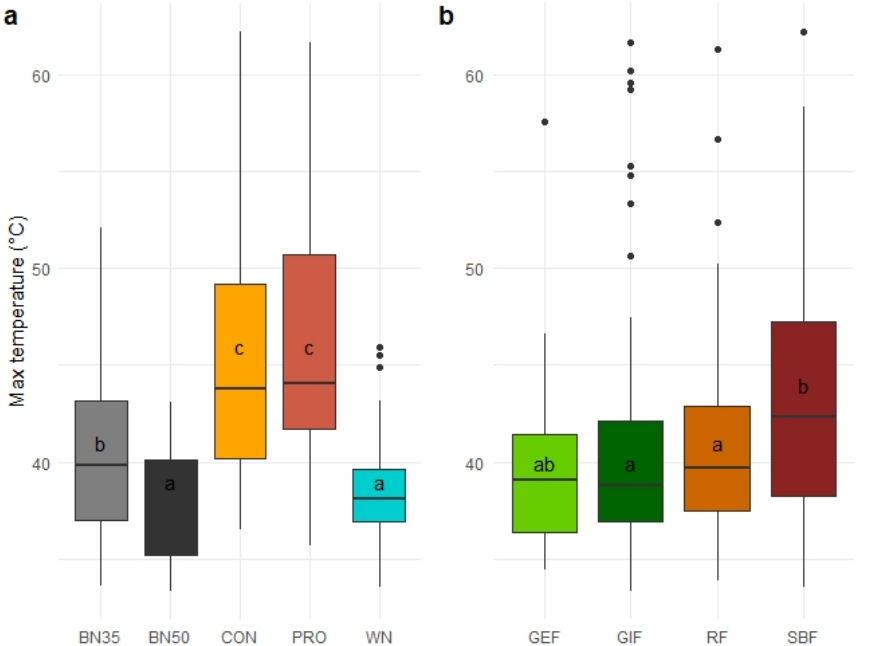
Figure 3. Maximum fruit surface temperature (FST) according to: ( a ). treatment (BN35 = Black net 35, BN50 = Black net 50, WN = White net, CON = control and PRO = protectants), and ( b ). fruit condition (RF = red fruit, GEF = green external fruit, GIF = green internal fruit, and SBF = sunburned fruit). The box represents interquartile range (IQR); the upper (Q3) and lower (Q1) quartiles are the ends. The line in the box is the median and the whiskers are the range of the data, excluding outliers. Outliers are values higher than Q3 + 1.5 IQR or smaller than Q1 − 1.5 IQR. Boxes with different letters indicate significant differences ( α = 0.05).